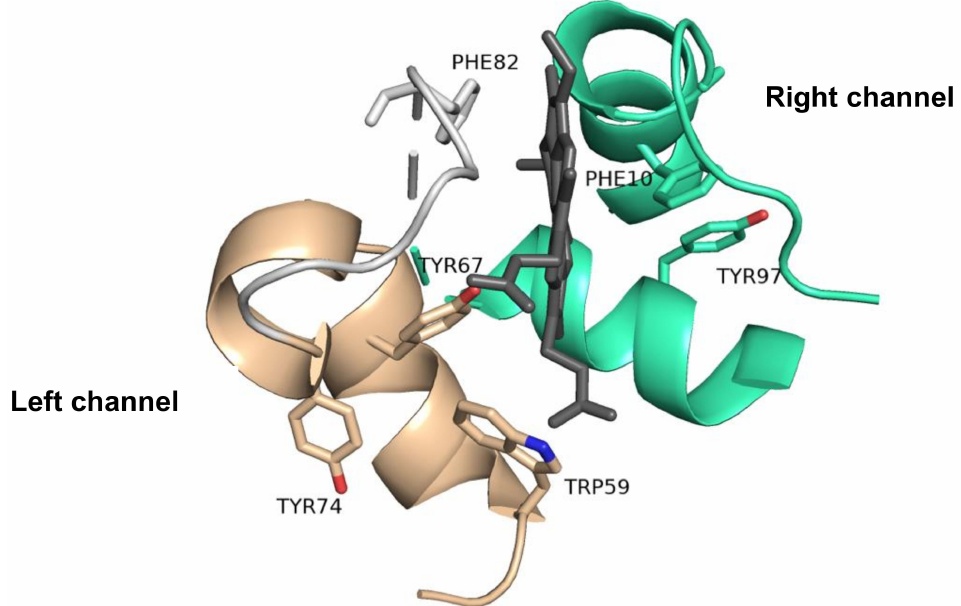
Figure 6. Left and right channels of Cyt c showing conserved aromatic residues that are in close proximity to the heme group and therefore are essential for the redox activity of the protein (PDB: